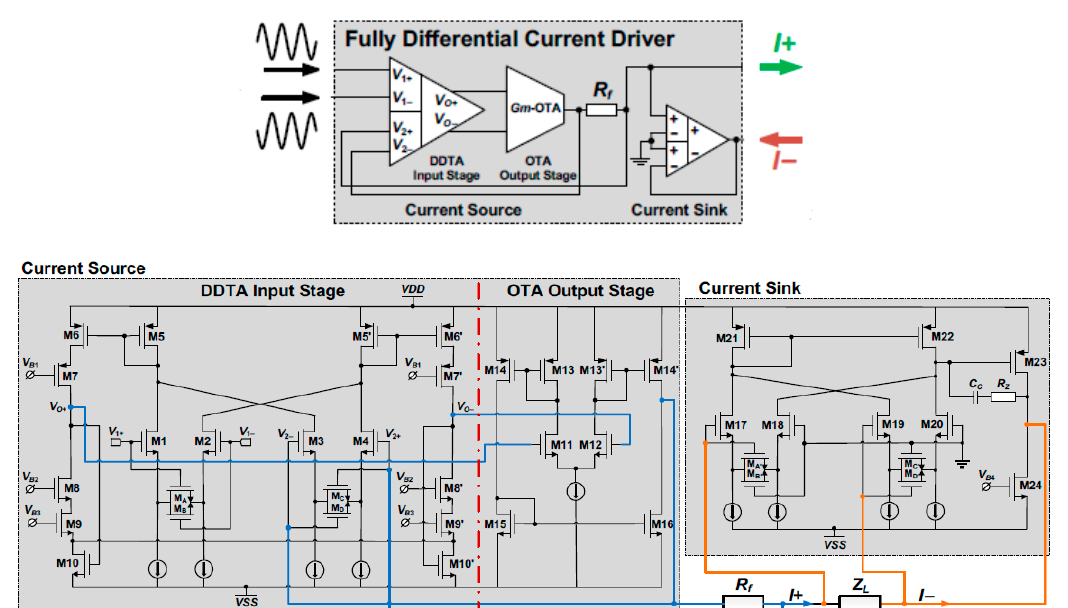
Figure 13. Circuit architecture of the current driver with common mode feedback (Reproduced from [23], with permission from the